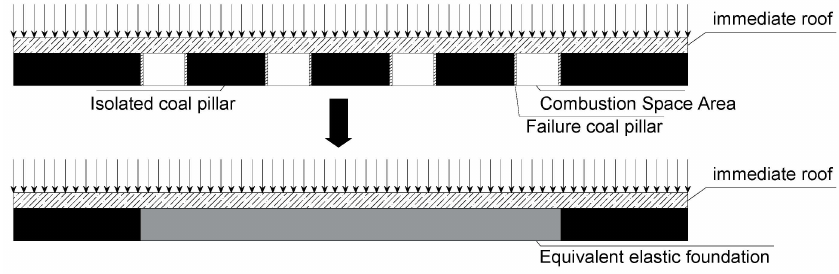
Figure 7. Schematic diagram of equivalent elastic